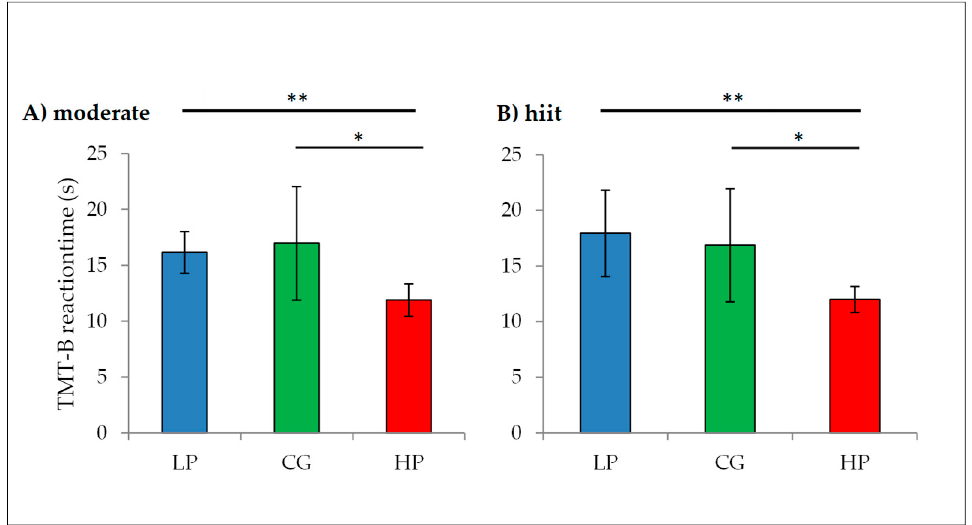
Figure 6. Post-hoc tests for TMT-B exemplary (reaction time in seconds). ( A ): moderate condition, ( B ): hiit condition. LCP = low cognitive performance ( n = 13), HCP = high cognitive performance ( n = 13), CG = control group ( n = 13). Lower reaction time reflects greater cognitive performance. * p < 0.05, ** p < 0.001. Error bars represents the mean ± one standard deviation.